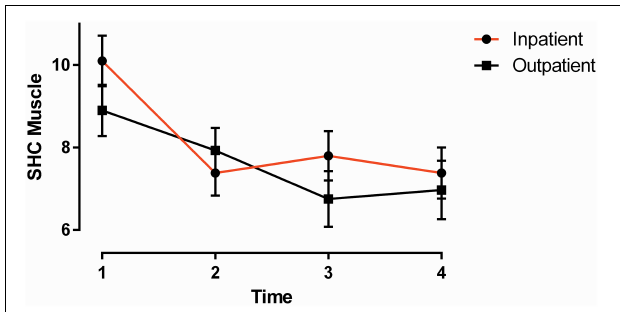
FIGURE 1 | SHC Musculoskeletal Pain: group by time. Vertical bars denote 1